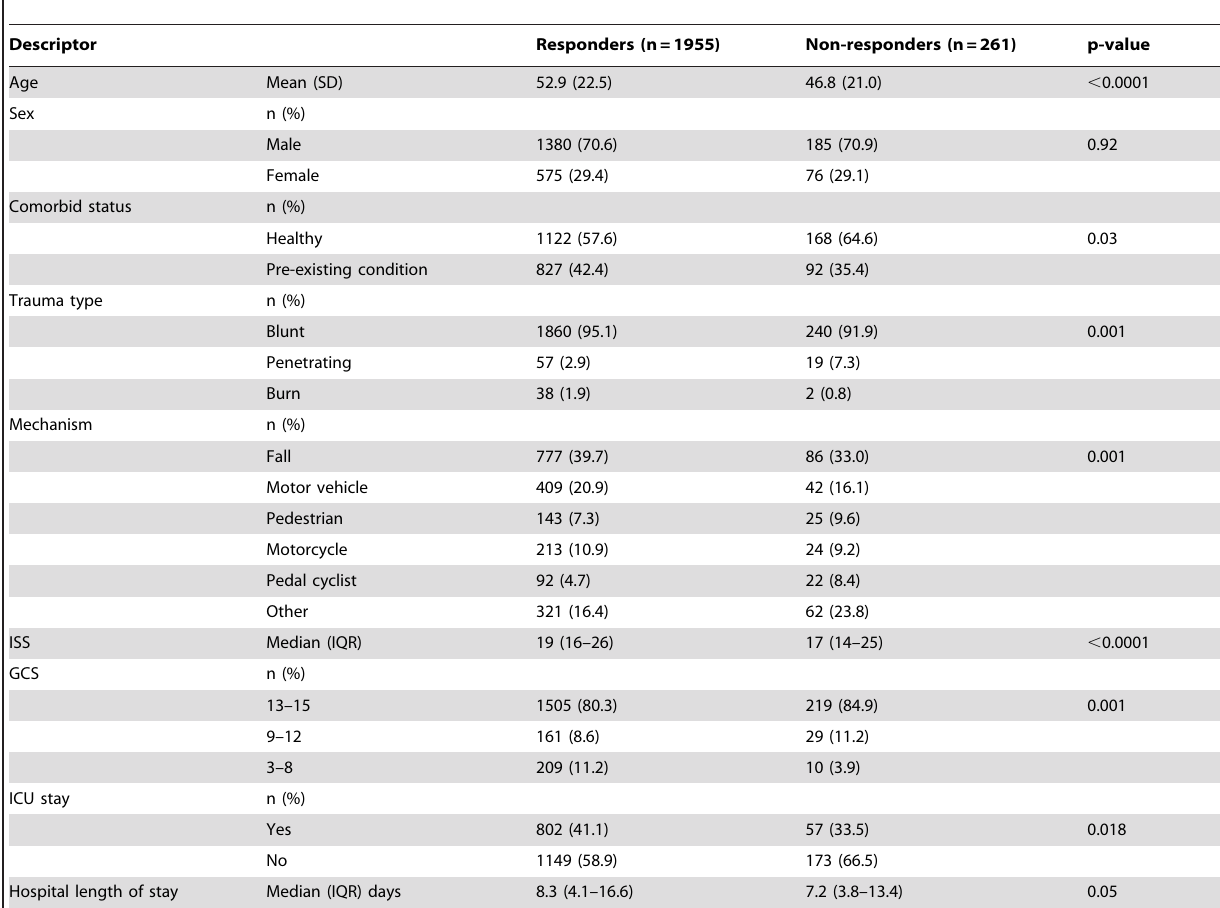
Table 2. Characteristics of responders and non-responders at